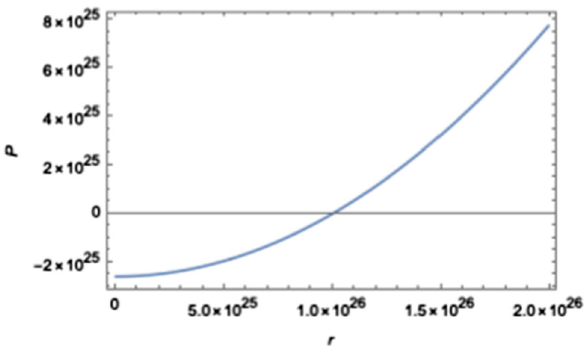
Fig. 1 Casimir pressure as a function of the distance